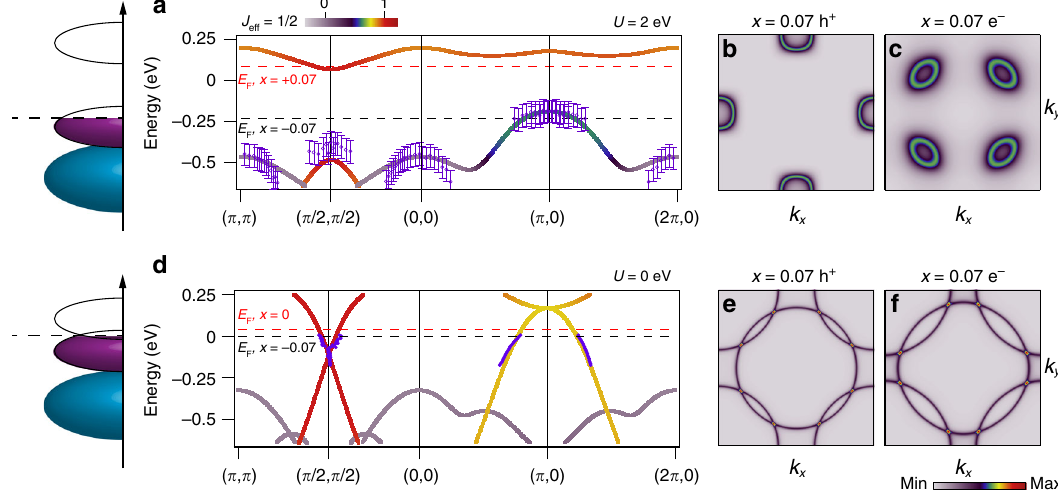
Fig. 4 Tight-binding model compared with extracted band dispersions. a Tight-binding model of the band structure with an additional mean- fi eld Coulomb repulsion term U = 2 eV illustrating the behaviour of undoped Sr 2 IrO 4 with extracted experimental dispersions of undoped Sr 2 IrO 4 shown (purple circles), together with a schematic density of states, error bars indicated estimated uncertainty due to broad bands characteristic of insulating Sr 2 IrO 4 . Dashed black line indicates the chemical potential with x = 0.07 hole doping in a rigid band shift scenario similar to Rh-doped Sr 2 IrO 4 , dashed red line indicates chemical potential with x = 0.07 electron doping. Simulated tight-binding Fermi surfaces in a rigid band shift scenario are shown for b hole and c electron doping. d Tight-binding model with U = 0 eV, where the Mott gap has collapsed with extracted experimental dispersions of Sr 1.93 K 0.07 IrO 4 (purple circles) together with a schematic density of states. Simulated tight-binding Fermi surfaces when U = 0 eV shown for hole e and electron doping f